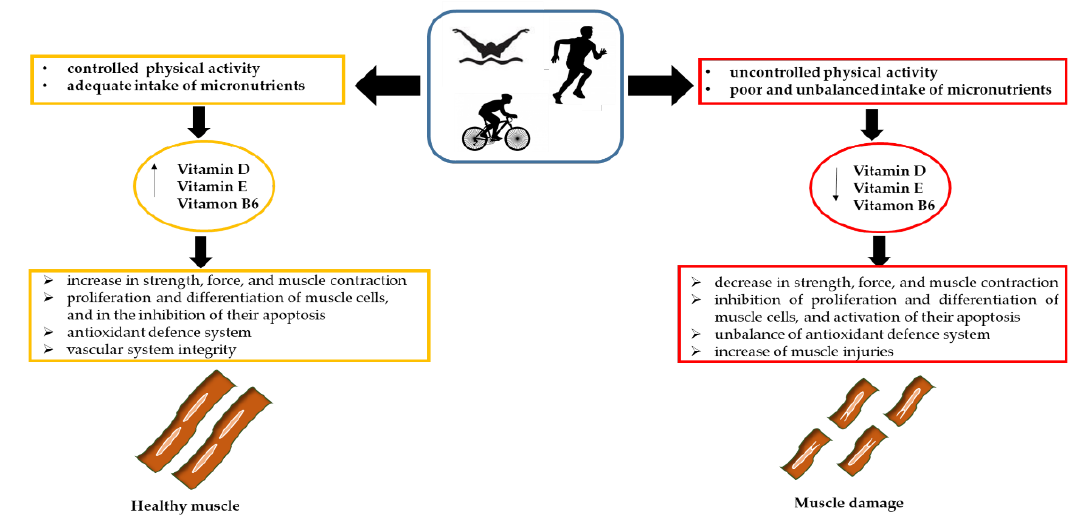
Figure 4. The role of vitamins in athletes’ muscle damage.